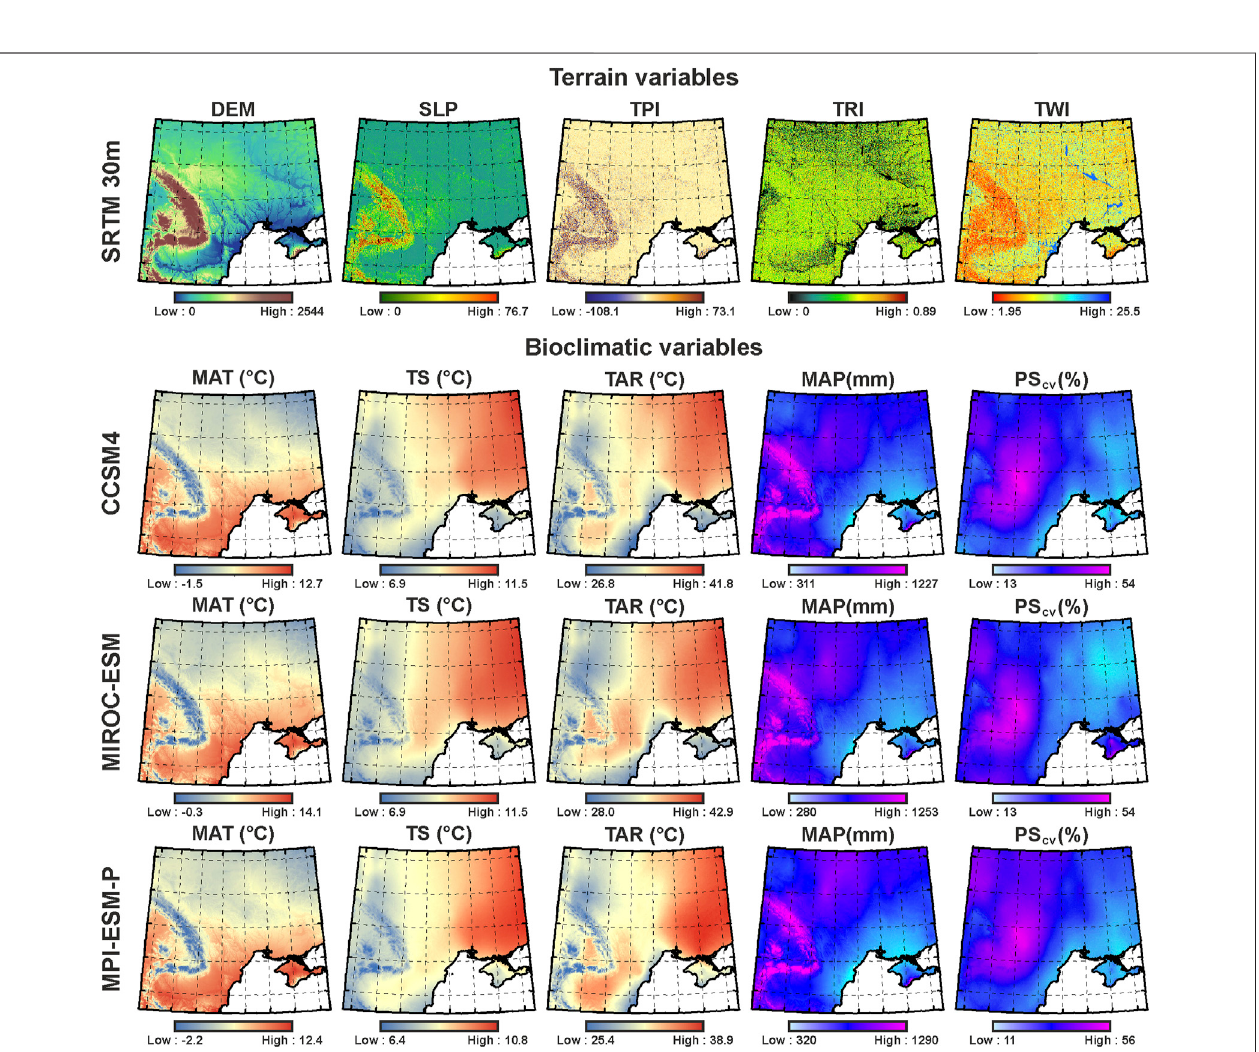
FIGURE 4 | Independent ecological variables selected to run the ECNM: terrain variables generated using DEM-derived raster from SRTM 30 m; mid-Holocene bioclimatic variables selected from three global climatic models (CCSM4, MIROC-ESM, and MPI-ESM-P) provided by the WorldClim 1.4 database.